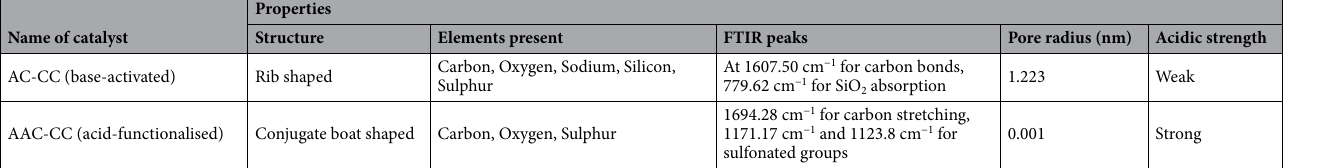
Table 5. Comparison of properties of base-activated and acid-functionalised activated